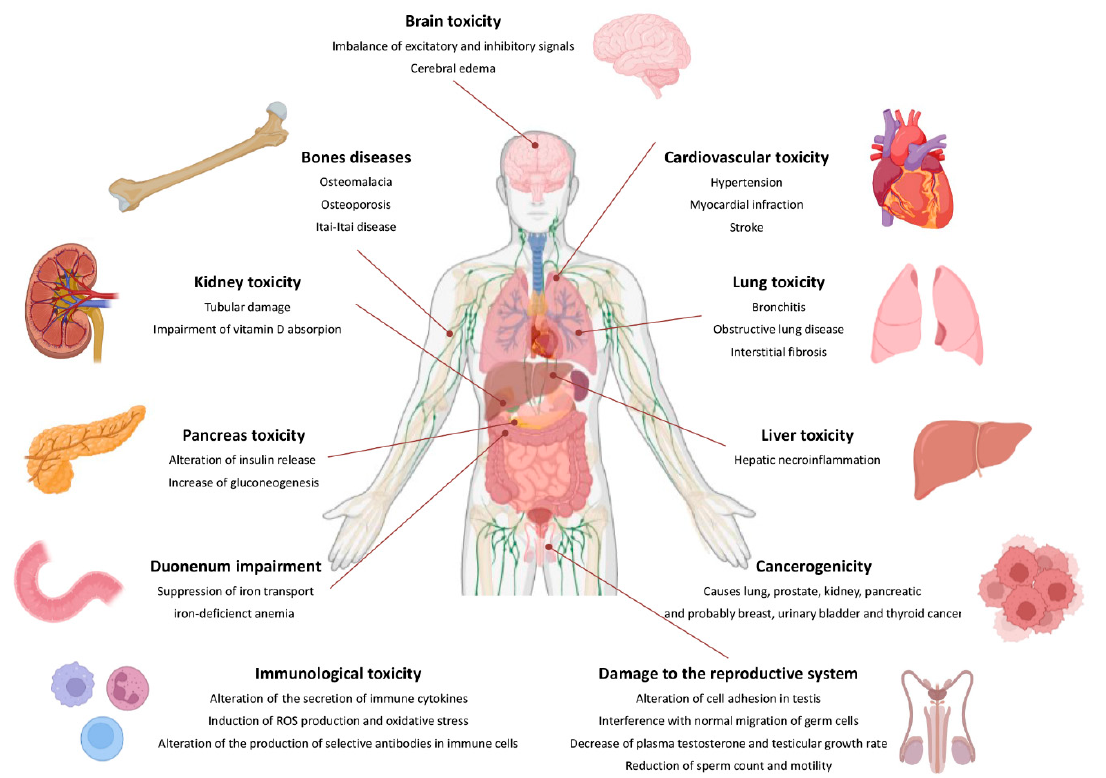
Figure 4. Outcomes of cadmium exposure.